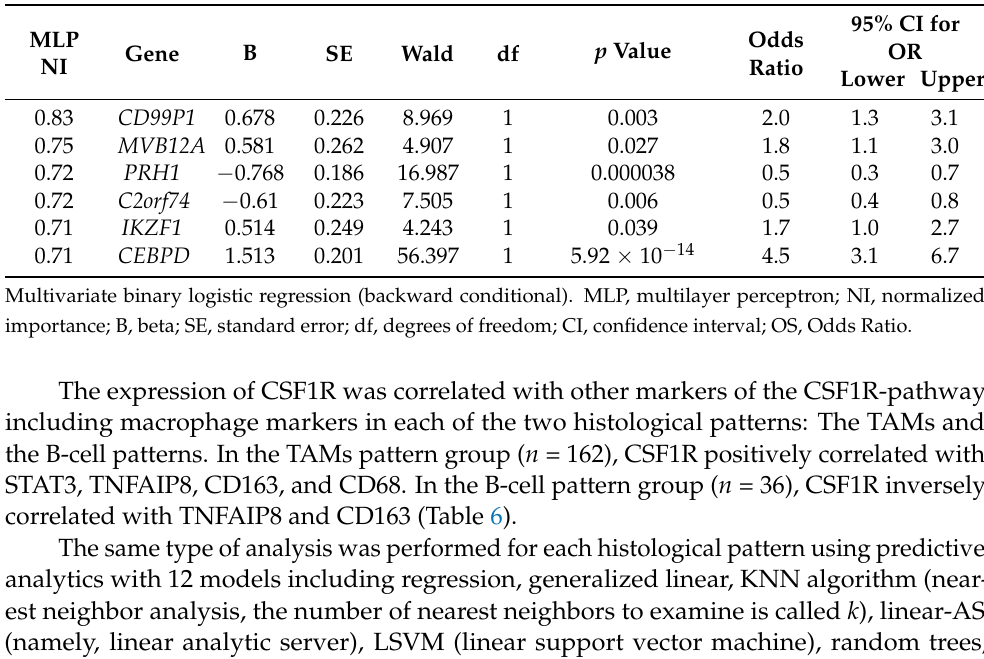
Table 7. Correlation between the gene expression of the top genes of the multilayer perceptron (MLP) with CSF1R (high vs.